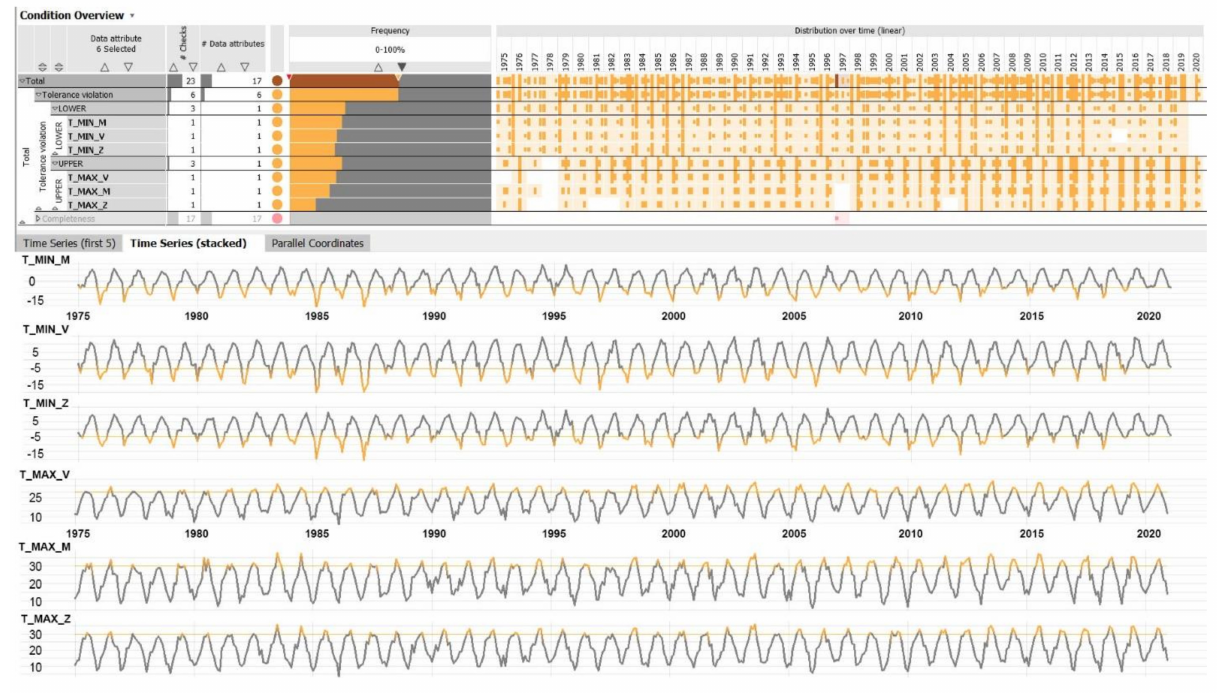
Figure 3. Threshold breach assessment of temperature time-series (minimum and maximum values).